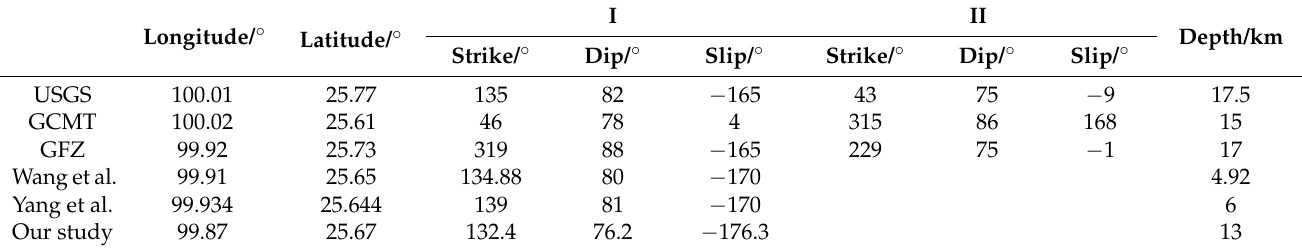
Table 2. Fault inversion parameters for the Yangbi Ms 6.4 earthquake.